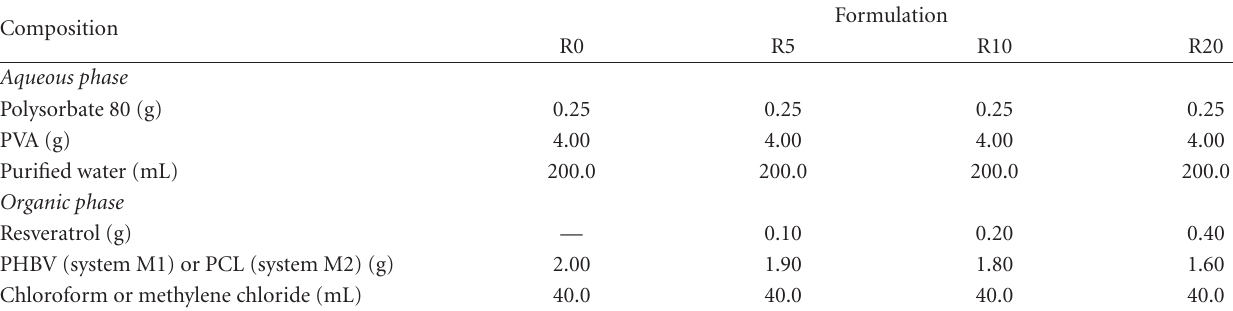
Table 1: Composition of resveratrol-loaded PHBV/PCL